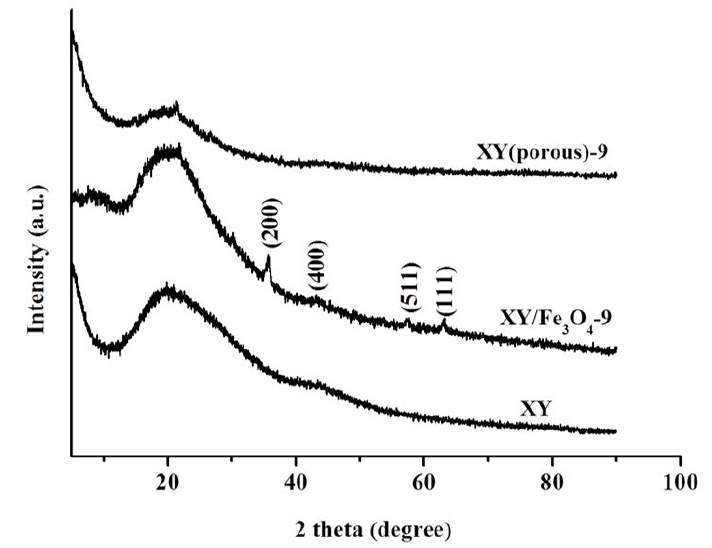
Figure 3. X-ray diffractometry (XRD) patterns of bare XY, XY/Fe 3 O 4 -9, and XY(porous)-9